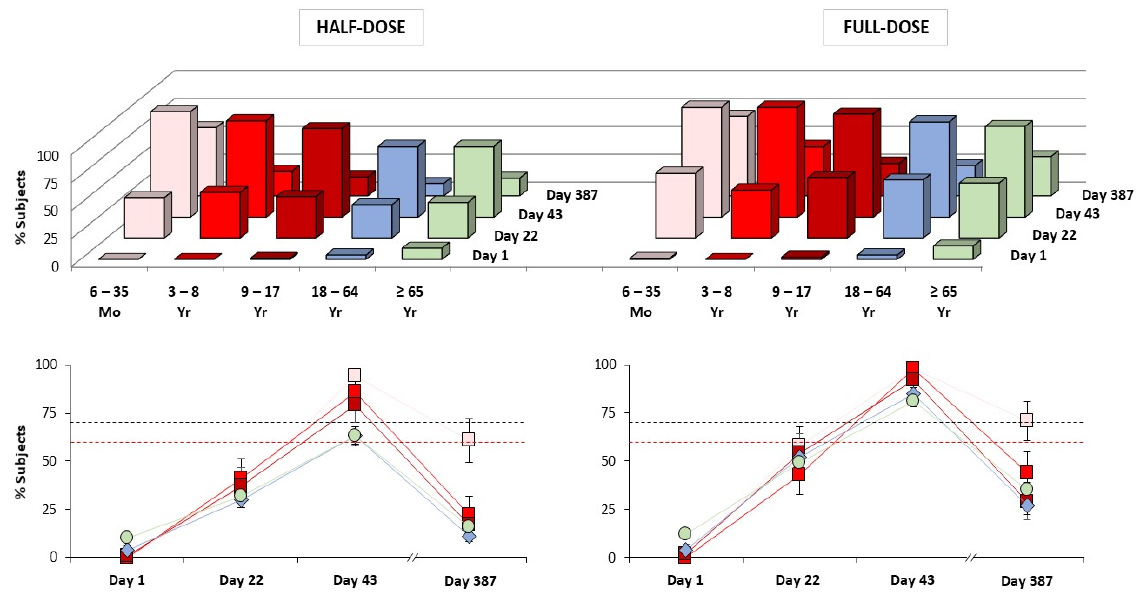
Figure 2. Percentages of subjects (95% CI) achieving hemagglutination inhibition antibody titers ≥ 1:40 at baseline (Day 1), three weeks after first dose (Day 22), and three weeks (Day 43) and twelve months (Day 387) after second dose administration. Data for subjects 6 months–17 years, 18–64 years, and ≥ 65 years of age derived from Studies A, B and D, respectively (Full Analysis Set data). Three-dimensional column graphs and line graphs show identical data in response to half-dose and full-dose formulations. Black broken lines indicate CBER and CHMP thresholds (70%) for HI ≥ 1:40 licensure criteria in adults, red broken lines indicate CBER and CHMP thresholds (60%) for older adults (refer to Table 4 for addi- tional information regarding CBER and CHMP licensure criteria).